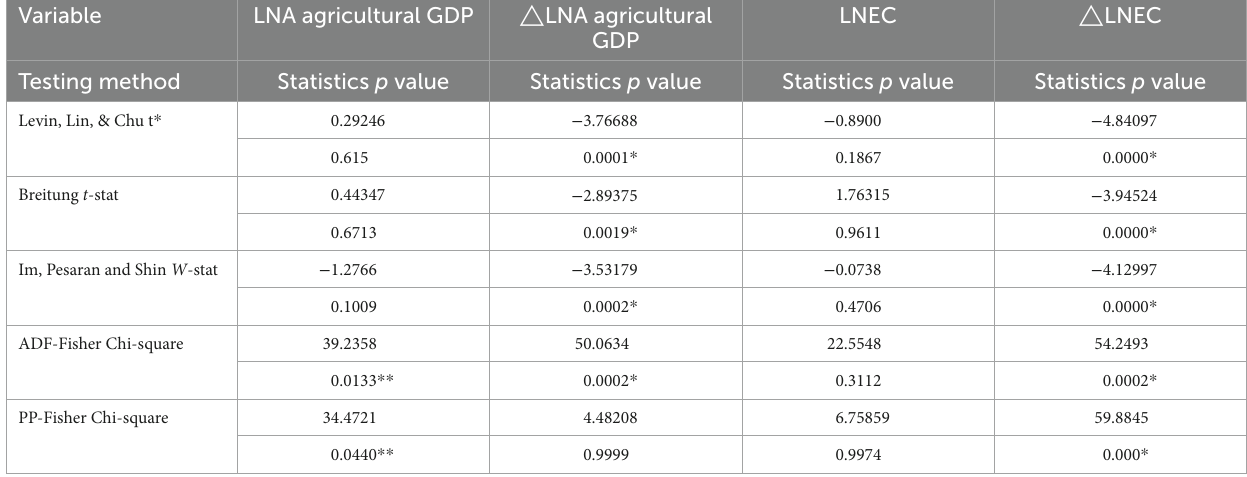
TABLE 1 Unit root test results of each variable in Class I blocks. Variable